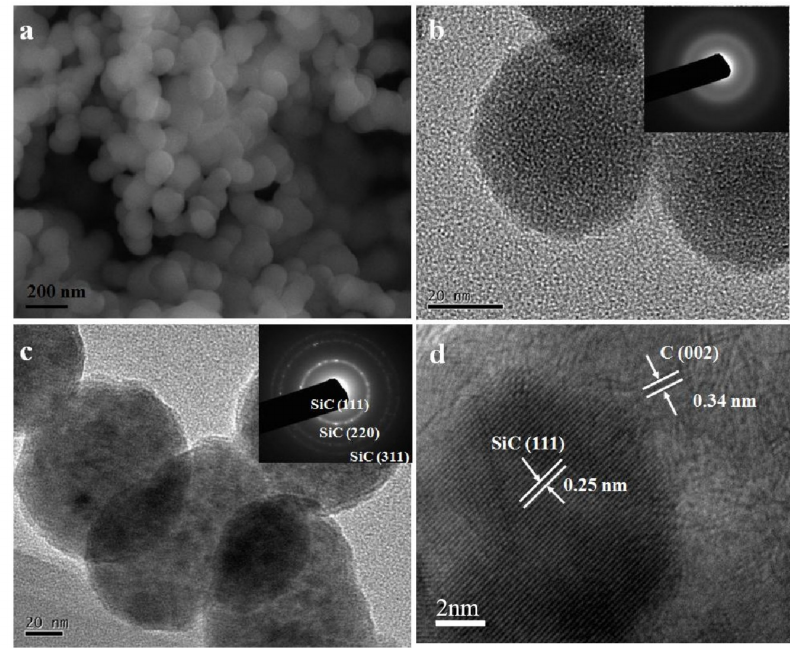
Figure 2. Morphologies of the SiC–C nanocomposites. ( a ) SEM and ( b ) TEM images of the SiC–C composite nanoparticles prepared at the FB − CVD temperature of 1000 ◦ C under pure Ar atmosphere (sample S1). ( c , d ) HRTEM images of S1 after heat treatment at 1300 ◦ C. The insets of ( b , c ) are the corresponding selected area electron diffraction (SAED) patterns of S1 before and after heat